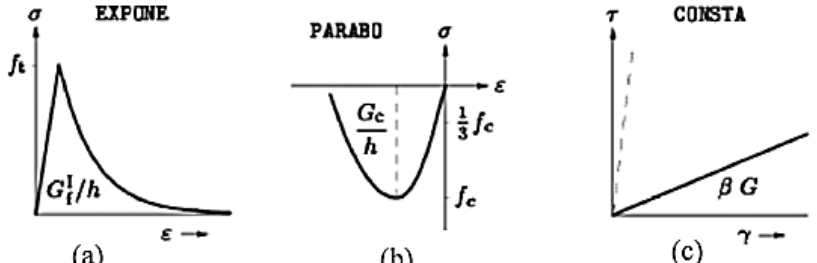
Figure 7. Mechanical behavior of the units used in numerical modeling: (a) tension, (b) compression, and (c) shear